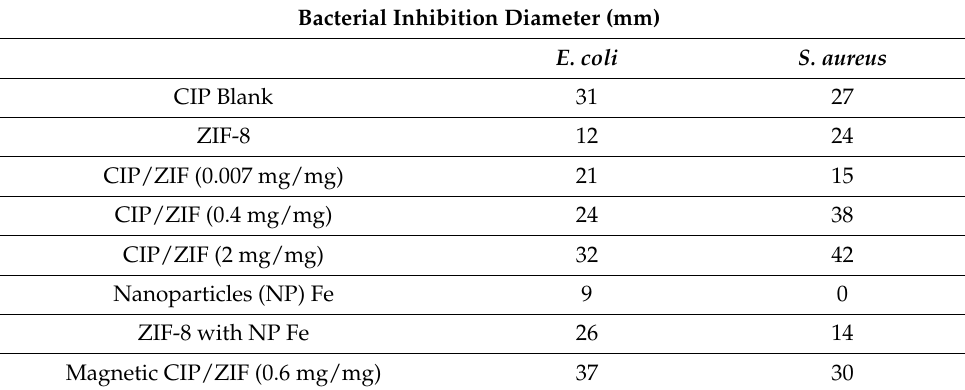
Table 2. Antimicrobial activity of the materials studied by inhibition halo measurement. Bacterial Inhibition Diameter (mm) E.